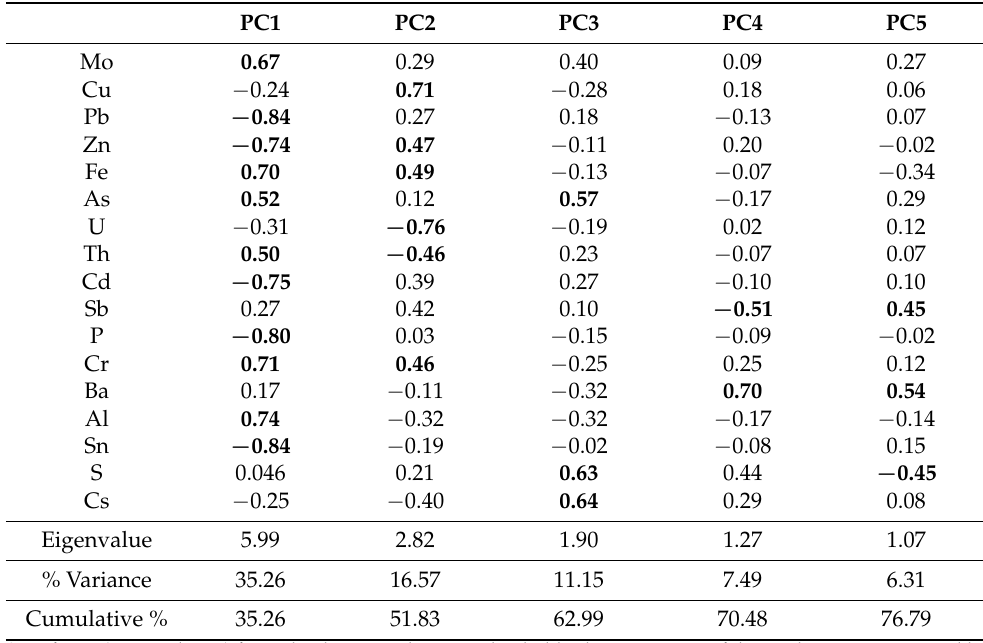
Table 6. Total variance and matrix of principal components